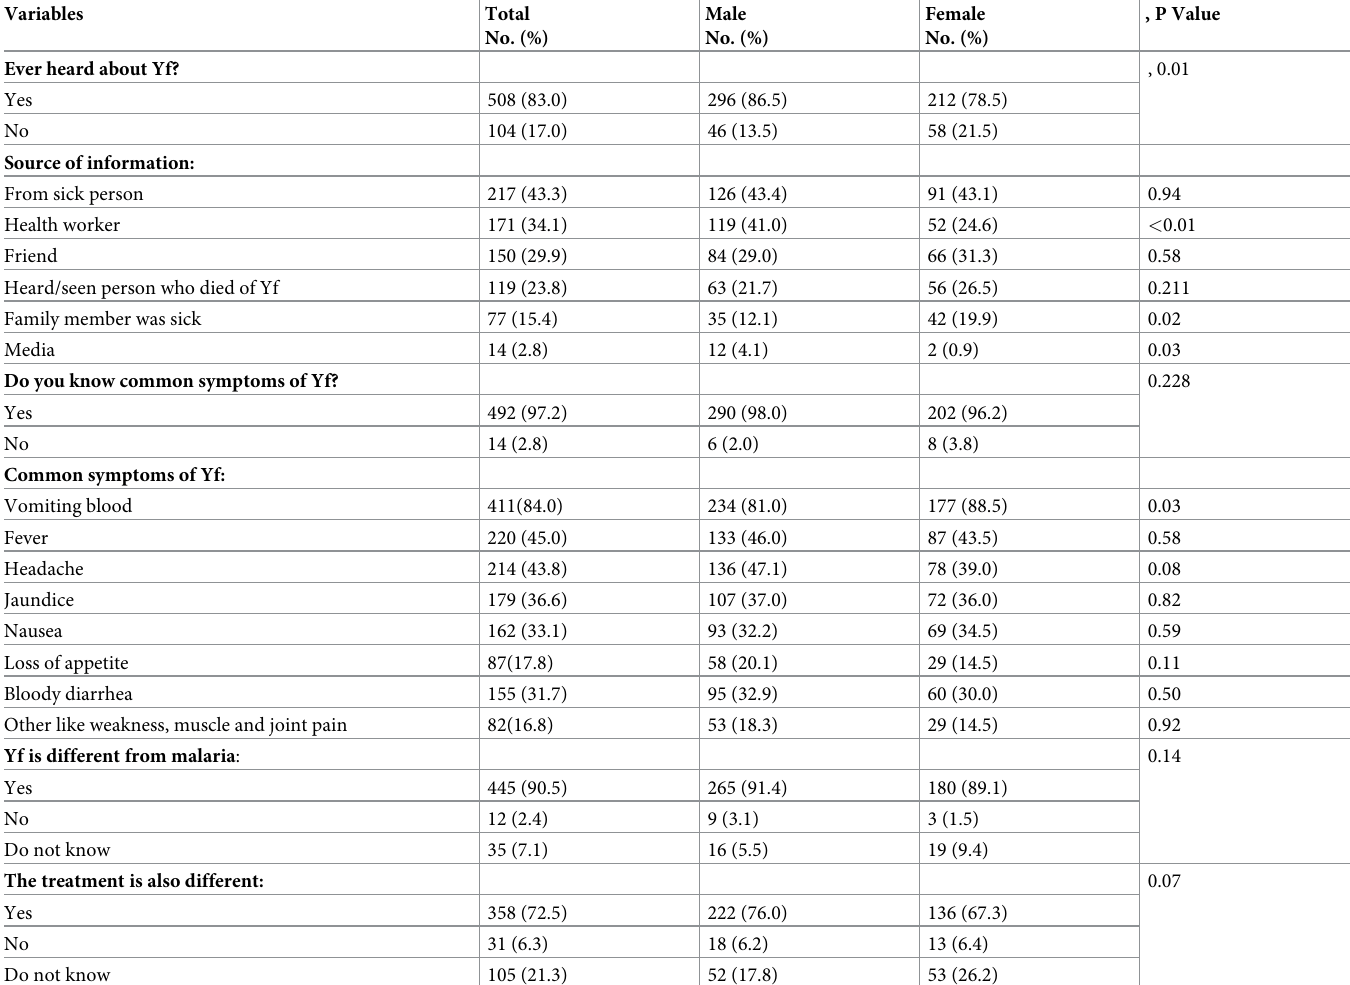
Table 2. Community’s knowledge of signs & symptoms of Yf and sources of